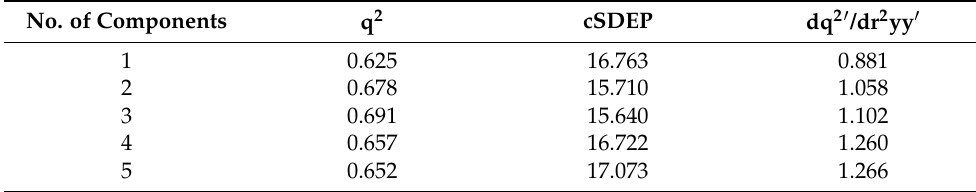
Table 2. Summary of progressive scrambling stability test for the CoMFA model.